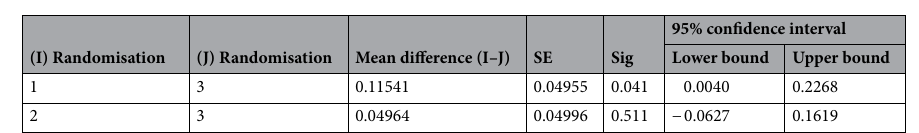
Table 3. Inter-group differences between pre- and post-treatment ETKA according to randomisation. One- way ANOVA Dunnett t-test for inter-group differences, treating group 3 as control, and comparing groups 1 and 2 against